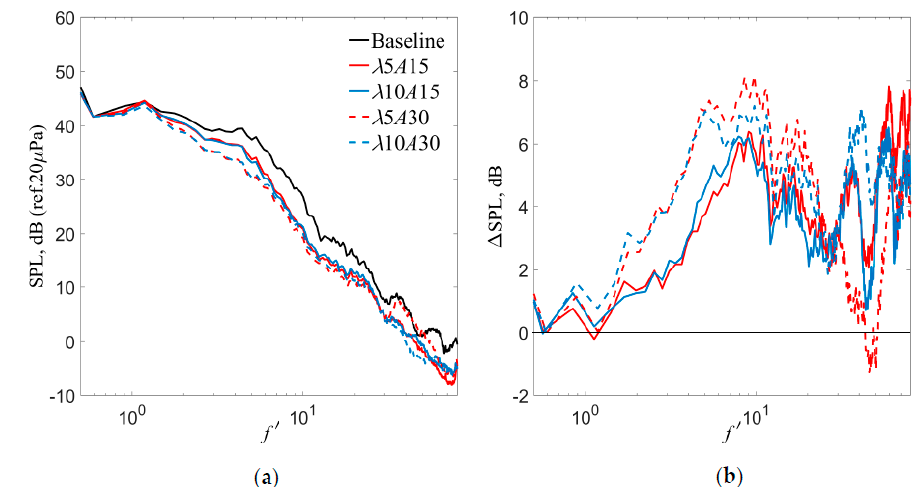
Figure 7. Comparison of ( a ) SPL and ( b ) Δ SPL as a function of normalized frequency f ‘ produced by the baseline and serrated leading edges at U = 25 ms − 1 and α = 0°.